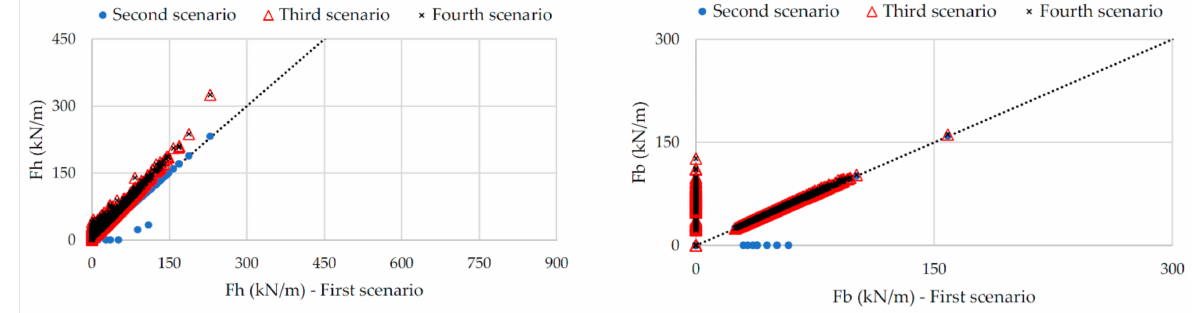
Figure 14. Horizontal and vertical forces for the first scenario compared with the second to fourth